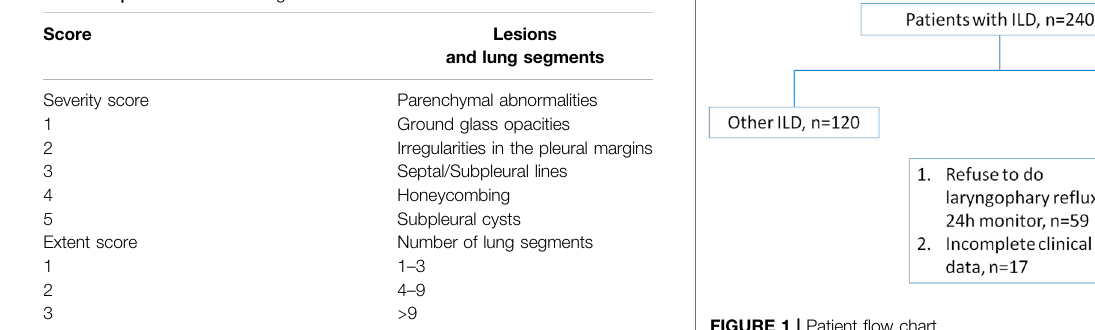
TABLE 1 | Chest HRCT scoring criteria.